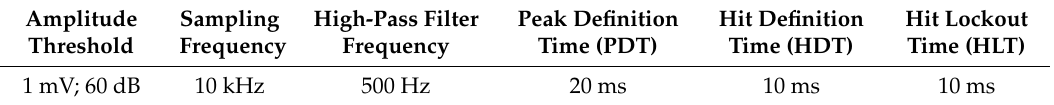
Table 3. Threshold, sampling frequency, high-pass filter, and time-parameters PDT, HDT, and HLT.